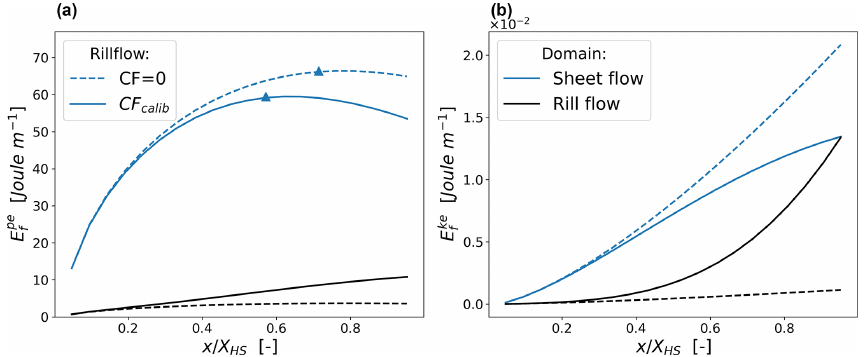
Figure 11. Spatial distribution of (a) E pe separated into sheet and rill